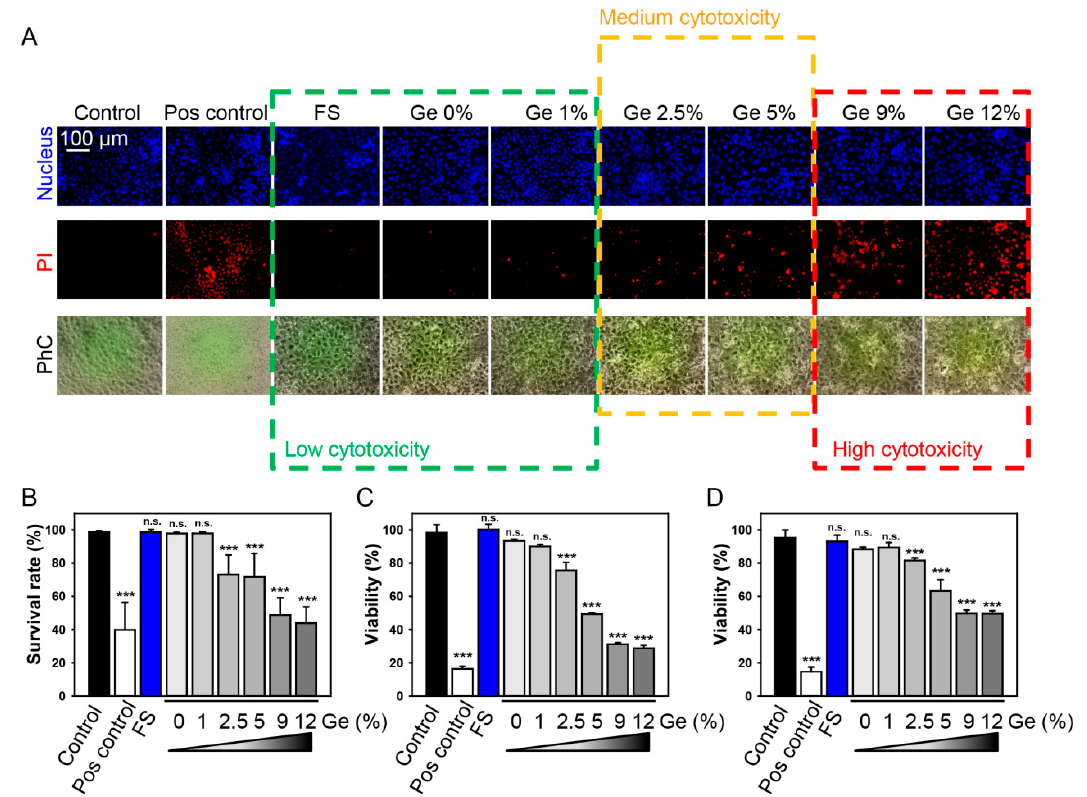
Figure 4. Cell viability of Huh7 cells on different Ge substrates after 5 days of cultivation. ( A ) Cells were stained with propidium iodide (PI, red) to assess cell viability. The nuclei were counterstained with Hoechst blue. Cells were imaged using epifluorescent microscope IM-2FL (OPTIKA Italy). Representative images are shown. As a positive control, cells were treated with 20% ethanol for 60 min. ( B ) Quantitative analysis of survival rate of cells grown on different Ge substrates. ImageJ software (NIH) was used for image processing and quantification. One-way ANOVA with Newman–Keuls multiple comparison test was used. Data are expressed as means ± SEM (n = 3), *** p < 0.001. ( C ) Cell viability as detected by the alamarBlue assay of Huh7 grown on different Ge substrates for 5 days, n = 3 each. The data were normalized to control values (no Ge exposure), which were set as 100% cell viability. As a positive control, cells were treated with 20% ethanol for 60 min. One-way ANOVA with Newman–Keuls multiple comparison test was used. Data are expressed as means ± SEM (n = 3), *** p < 0.001. ( D ) Cell viability as detected by the calcein AM assay of Huh7 grown on different Ge substrates for 5 days, n = 3 each. The data were normalized to control values (no Ge exposure), which were set as 100% cell viability. As a positive control, cells were treated with 20% ethanol for 60 min. One-way ANOVA with Newman–Keuls multiple comparison test was used. Data are expressed as means ± SEM (n = 3), *** p < 0.001.